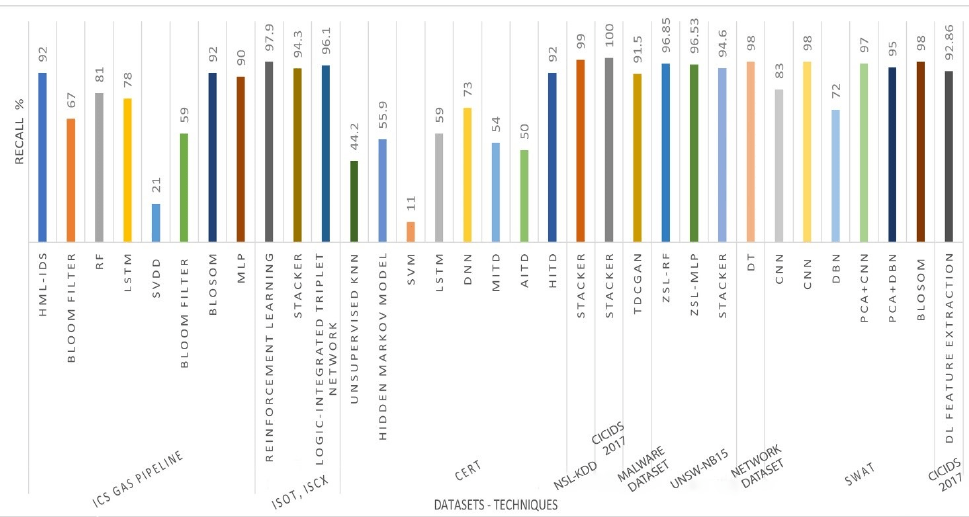
Figure 7. Recall of the compared techniques on different datasets.